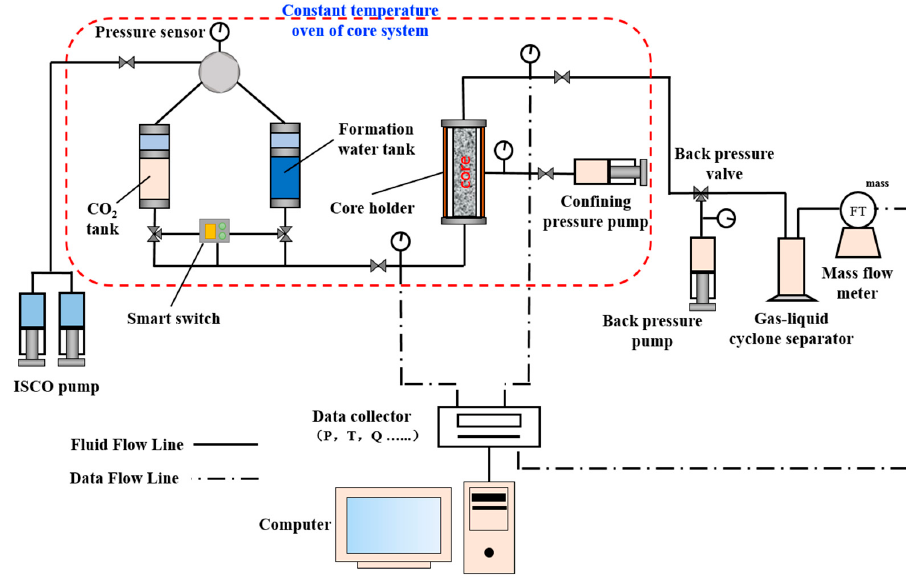
Figure 3. Schematic diagram of flooding experiment.